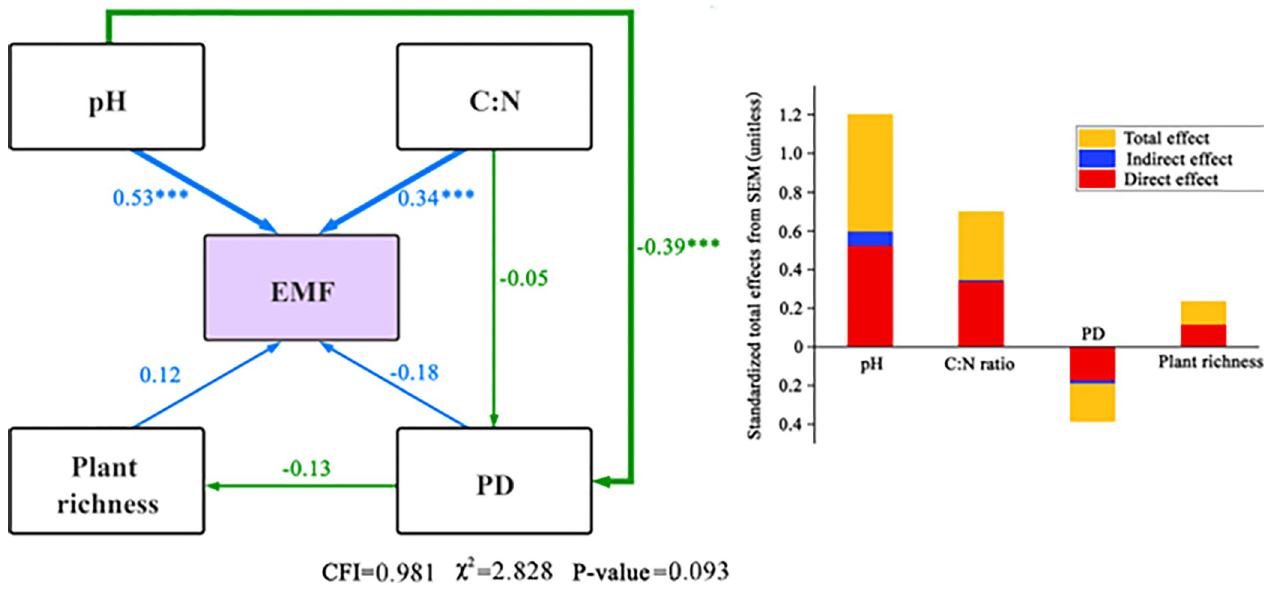
Fig 8. Structural equation model of plant diversity and abiotic factors with ecosystem